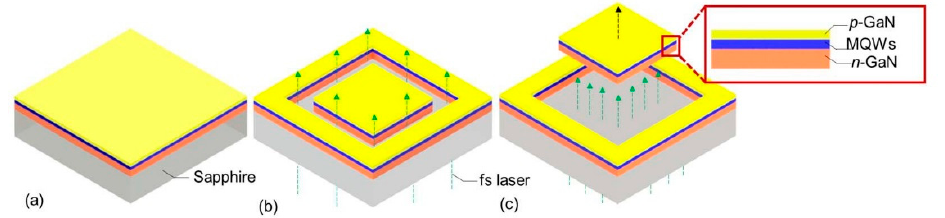
Figure 2. ( a ) Sketch of InGaN/GaN LED wafer. LLO process flow using two-step laser ablation from backside showing ( b ) material removal with high laser fluence for selectively creating the outer frame surrounding the to-be-lifted-off GaN chip and ( c ) scanning with lower laser fluence for releasing the GaN chip from the sapphire